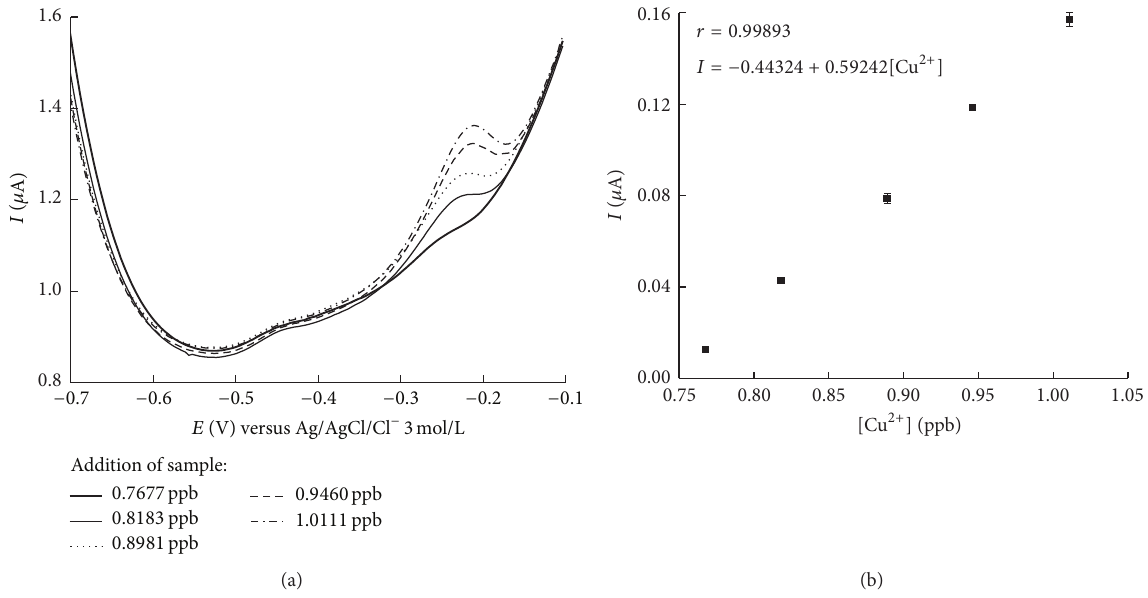
Figure 5: Determination of Cu 2+ ion by DPASV in GC/CNT/nanoAu-SiO 2 , in a sample of drinking water and in HCl pH 1 medium with preconcentration time of 300 s. (a) Voltammogram. (b) Analytical calibration curve.